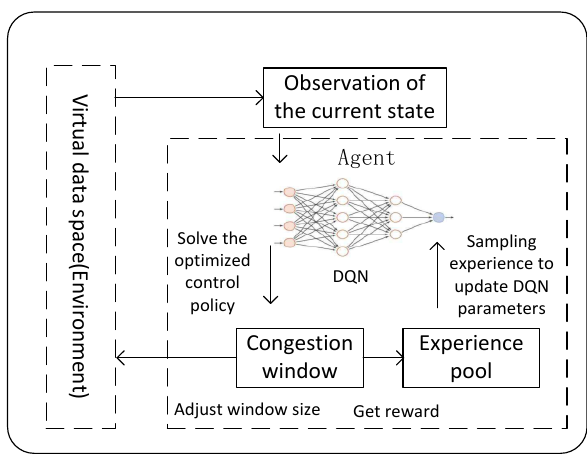
Figure 2. TCP–DQN Figure 2. TCP–DQN framework.